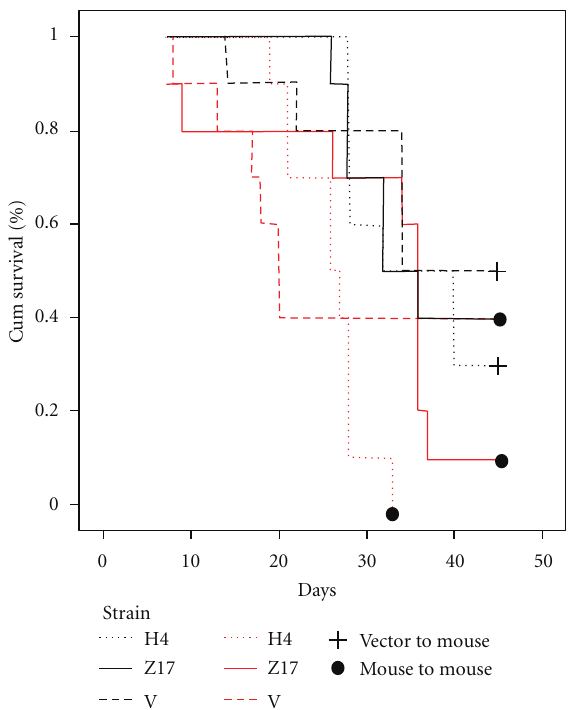
Figure 5: Survival rate of T. cruzi strains H4, Z17, and V in BALB/c mice infected “mice to mice” and “triatoma to mice” during 45 days.